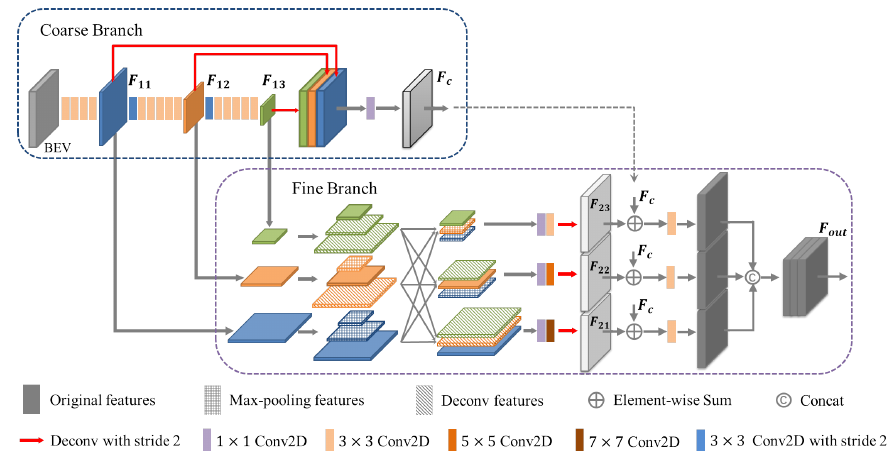
Figure 3. The structure of our proposed backbone network PFH-PSA. The red arrows indicate deconvolution layers, purple boxes indicate 1 × 1 convolutional layers, light yellow boxes indicate 3 × 3 convolutional layers, orange boxes indicate 5 × 5 convolutional layers, brown boxes indicate 7 × 7 convolutional layers, and blue boxes indicate the convolutional layers with stride = 2. Different colors indicate feature maps with different scales, and different textures indicate feature maps obtained through deconvolution layers or max-pooling